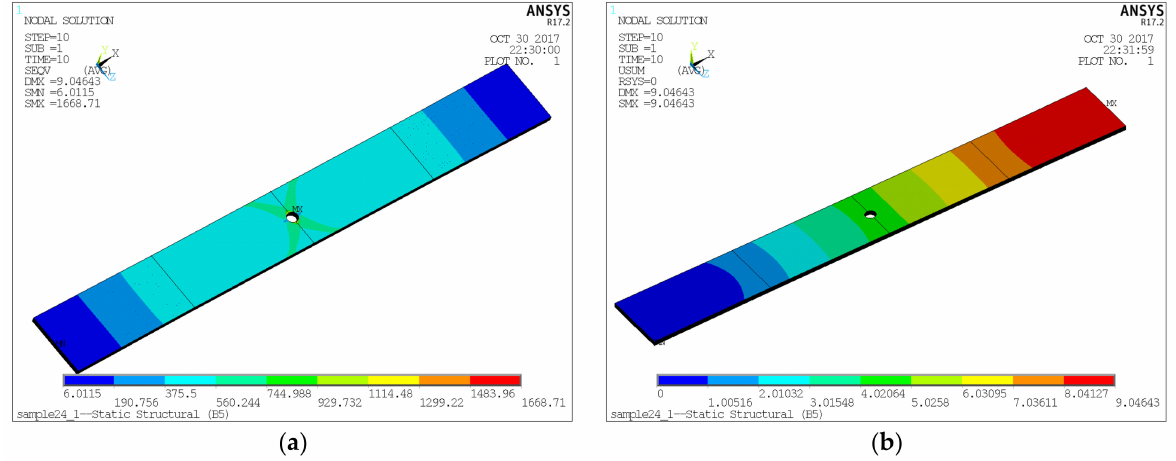
Figure 8. Example of equivalent stress ( a ) and displacement ( b ) calculations of the specimen with a hole under